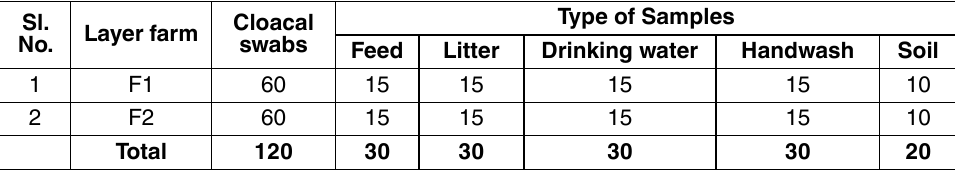
table 1. Details of samples collected from layer farms sl. No.